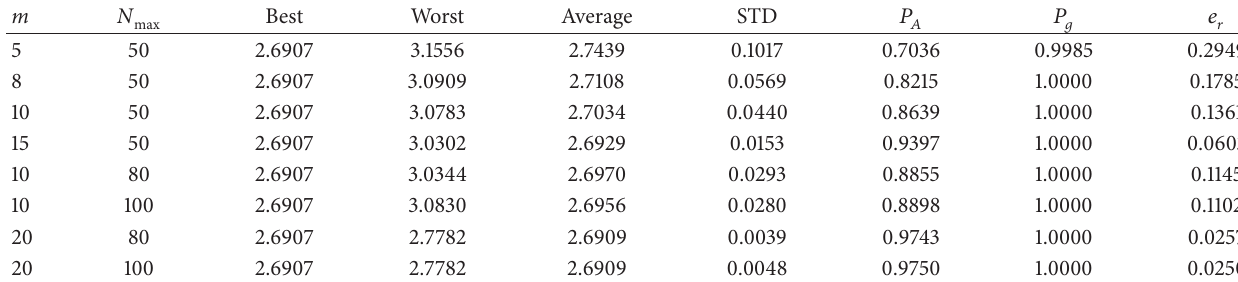
Table 4: Experimental comparison for